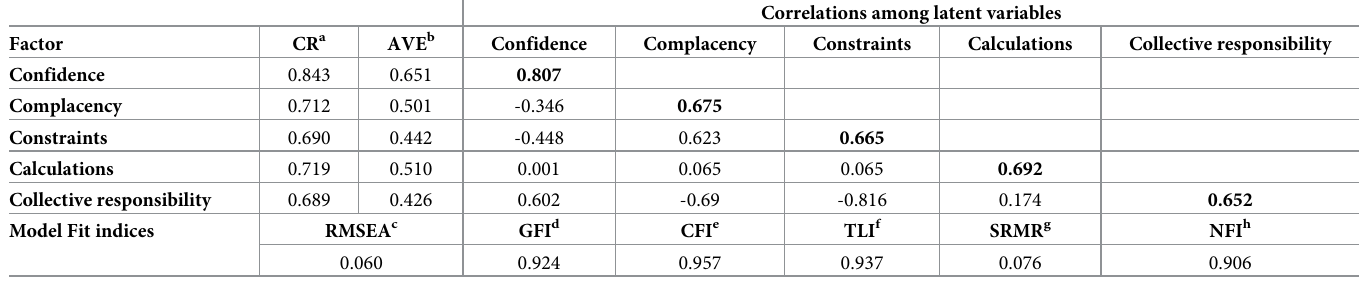
Table 6. Results of the confirmatory factor analysis of 5C scale (15 items). Convergent validity, discriminant validity, and reliability assessment of CFA final model with five latent factors and model fit